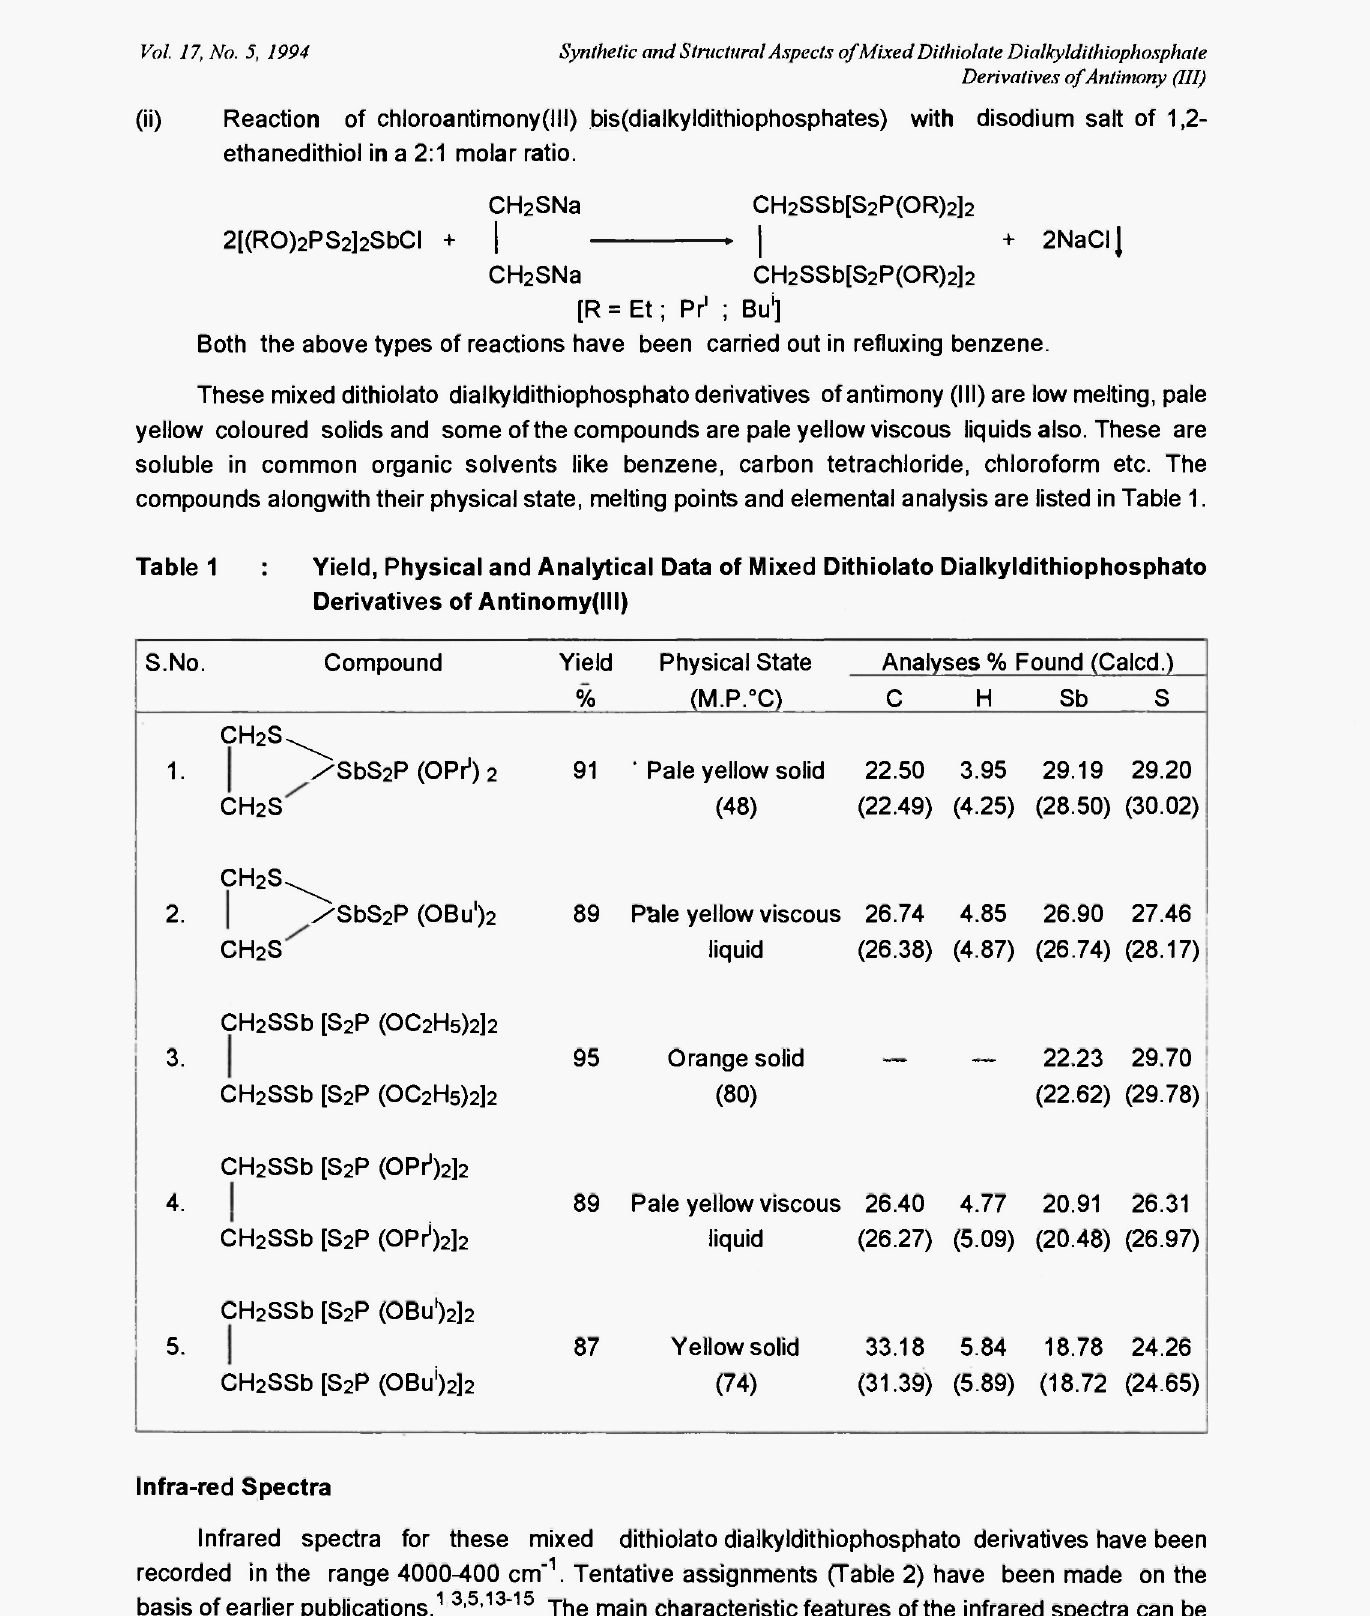
Yield, Physical and Analytical Data of Mixed Dithiolato Dialkyldithiophosphato Derivatives of